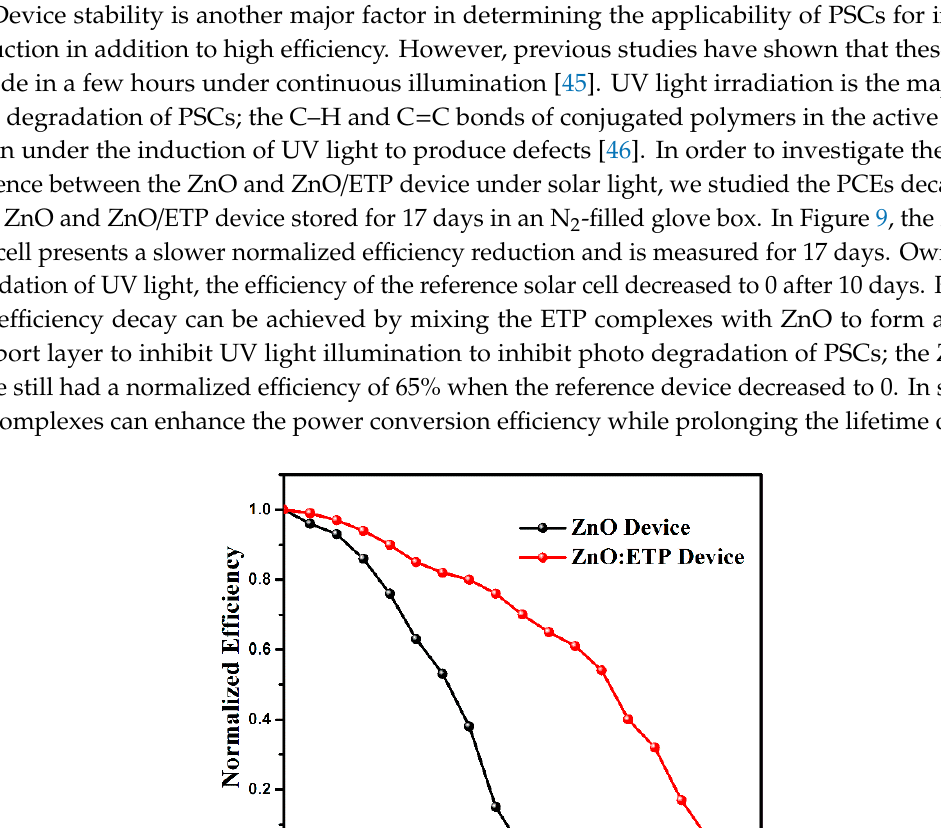
Figure 8. ( a ) Photocurrent density versus effective voltage curves under AM1.5 G illumination at 100